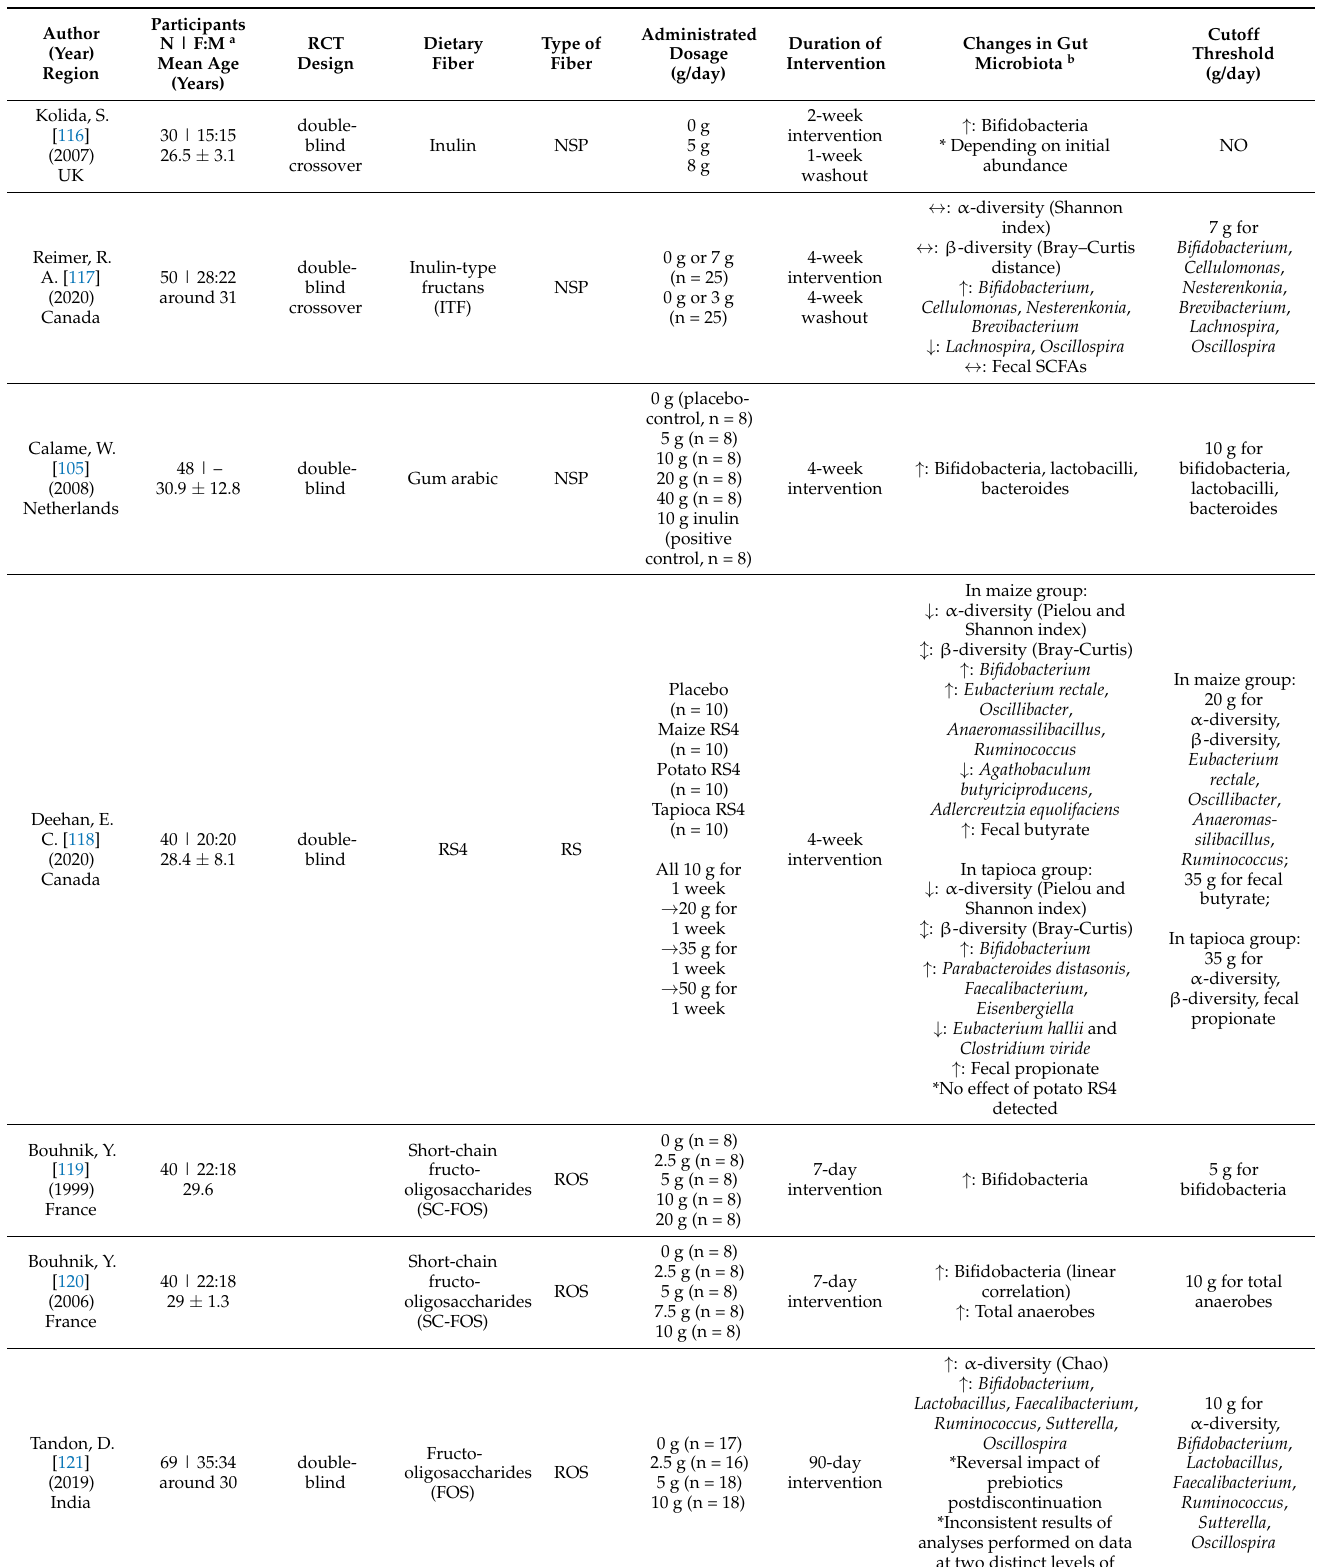
Table 2. Cutoff thresholds of dietary fiber on gut microbiota in intervention